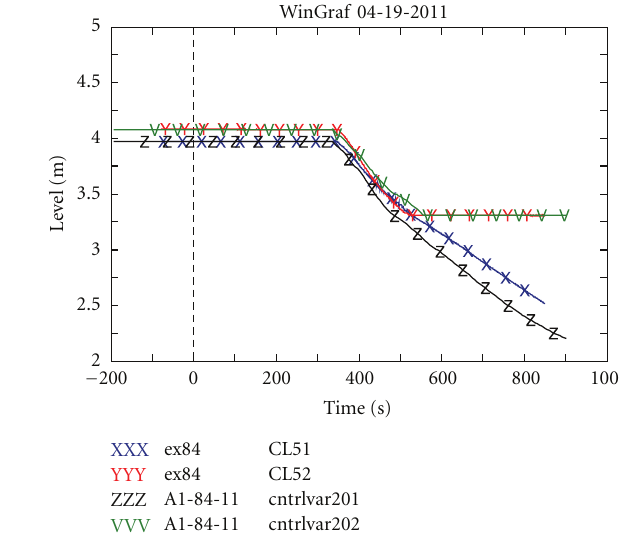
Figure 20: Primary system pressure.